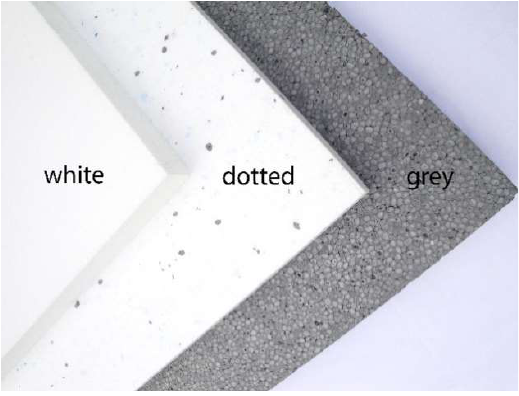
Figure 1. The tested products: A—“white” expanded polystyrene (EPS) (pure), B—“dotted” EPS, and C—“grey” EPS.